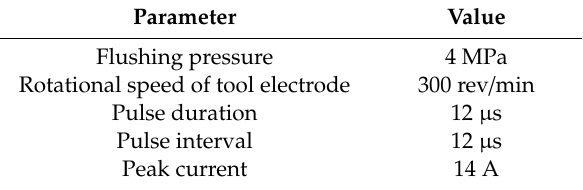
Table 3. Experimental parameters of the electrochemical reaming